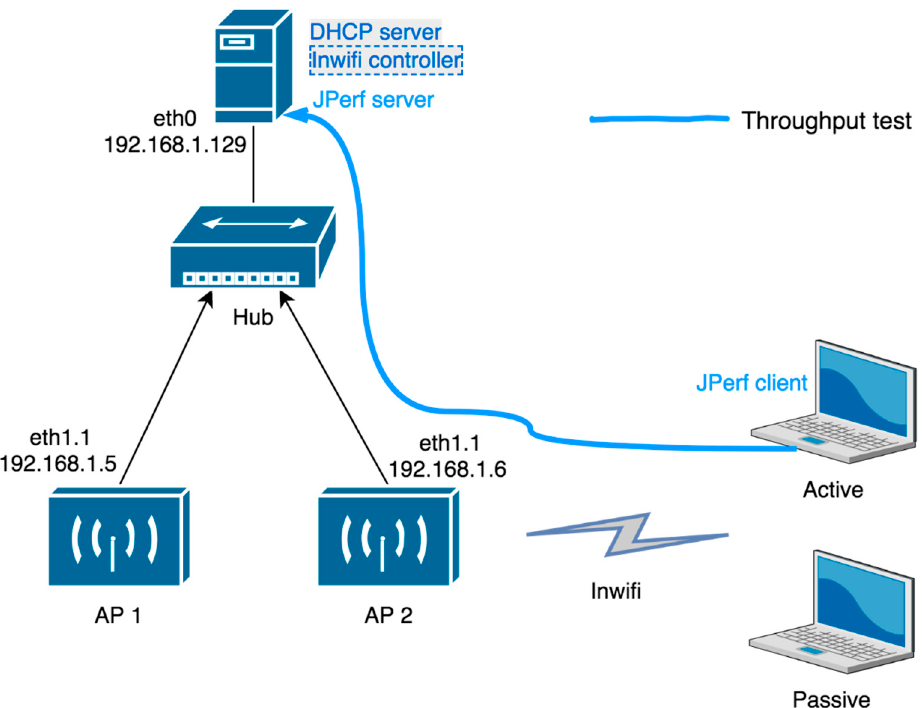
Figure 8. Testbed topology.